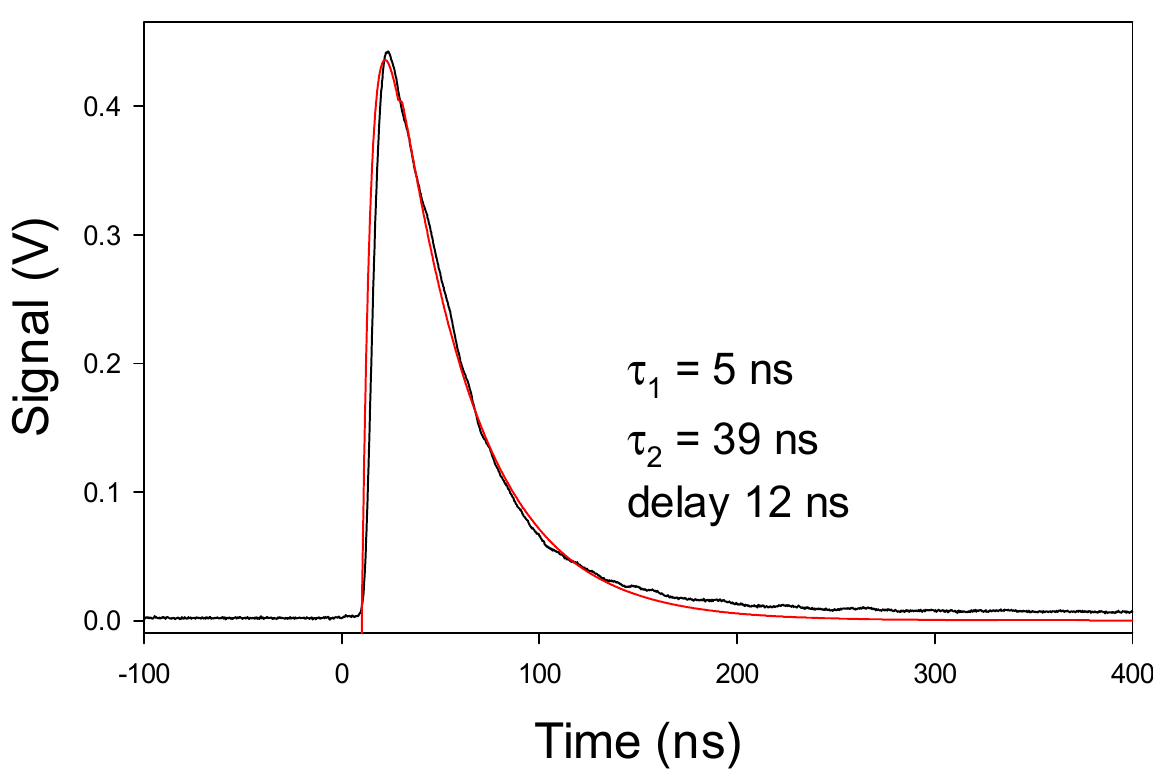
Figure 4. Decay of charged pions time-dilated to 39 ns. D(0), 0.2 mbar D 2 , collector at 94 cm, − 50 V bias. 0.4 J, 10 Hz pulse repetition, 1064 nm light.